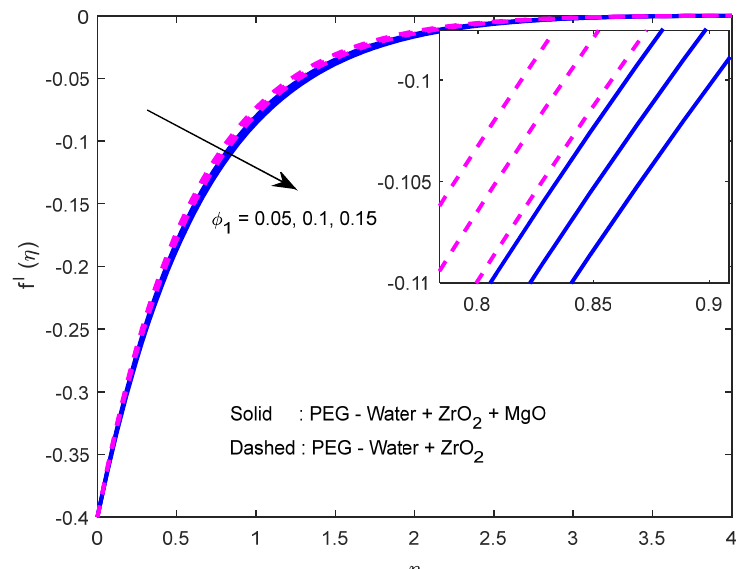
Figure 9. Effects on velocity due to φ 1 .